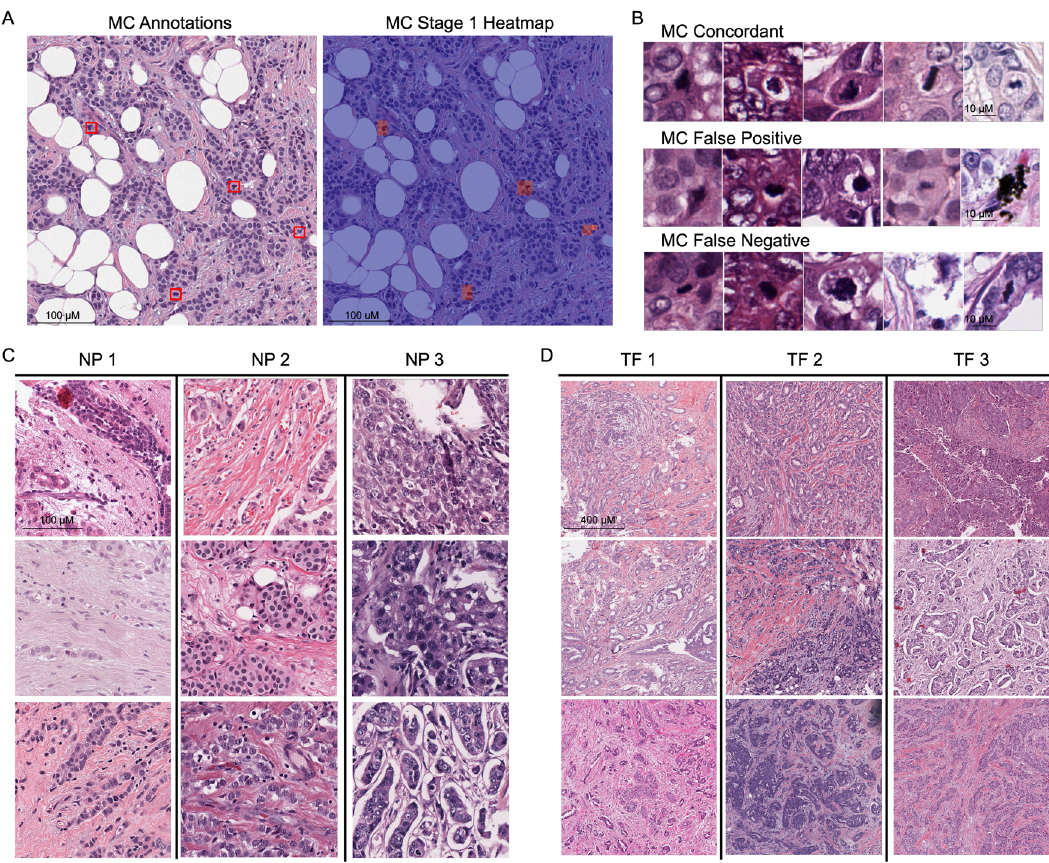
Fig. 2 Visualization of patch-level DLS predictions. A Pathologist annotations for mitoses corresponding to a single high-power fi eld of 500 μ m × 500 μ m (left) and the corresponding heatmap overlay provided by the MC model (right). Red regions of the overlay indicate high likelihood of a mitotic fi gure according to the model. B Patches corresponding to regions for which pathologists and the model both identi fi ed mitotic fi gures (concordant), regions classi fi ed as mitotic fi gures by the model but not identi fi ed by at least 2 of 3 reviewing pathologists (false positive), or regions identi fi ed by at least 2 of 3 reviewing pathologists as containing a mitotic fi gure but not classi fi ed as such by the model. Discordant identi fi cation of mitotic fi gures by the model did not appear to be due to image or staining quality, but rather, appeared to largely re fl ect morphologic details for which pathologist identi fi cation of mitotic fi gures was also variable. Patches are 32 μ m x 32 μ m with scale bar of 10 μ m shown in the top row. C Individual patches classi fi ed as grade 1, 2, 3 for nuclear pleomorphism. (40× magni fi cation; 256 μ m × 256 μ m; 100 μ m scale bar for reference). D Individual patches classi fi ed as grade 1, 2, or 3 for tubule formation (10× magni fi cation; 1 mm × 1 mm; 400 μ m scale bar for reference). MC mitotic count, NP nuclear pleomorphism, TF tubule